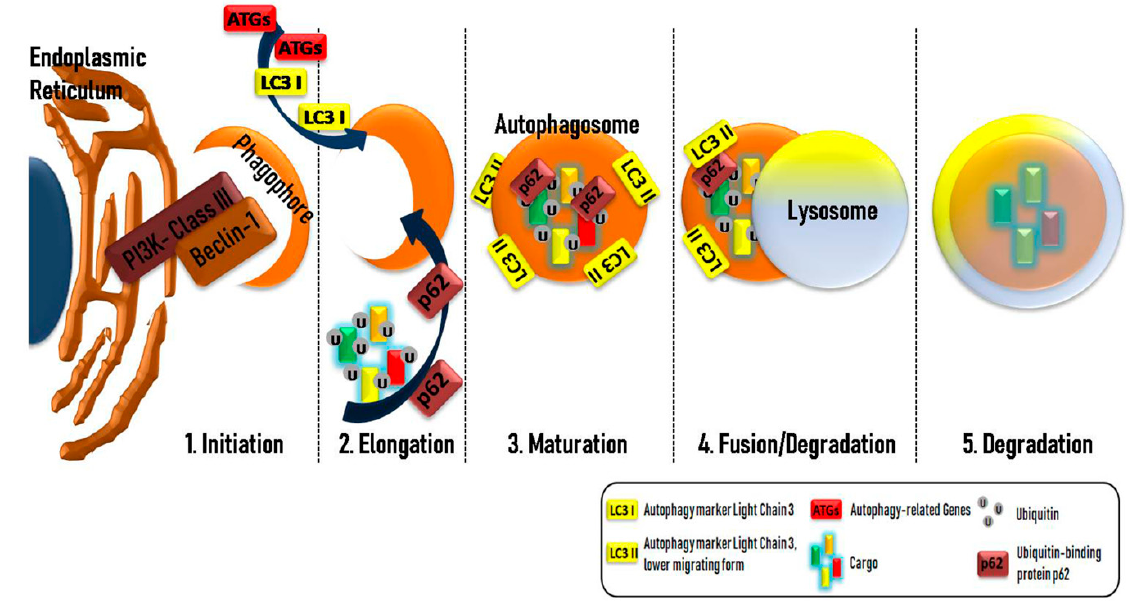
Figure 1. The main steps of autophagosome formation in cells. A plethora of different morphological changes occur during the autophagy process in order to form the autophagosome. The first step, or initiation (1), in this procedure, is the formation of a double-membrane structure, the phagophore, after the activation of a PI3K-classIII–Beclin-1 complex in the endoplasmic reticulum or other double-membrane organelles. Initiation is followed by the elongation (2) step, where the newly formed phagophore begins to enclose the ubiquitin-labeled cytosolic cargos. Different proteins, such as LC3 (light chain 3) (LC3-I is conjugated to phosphatidylethanolamine to form LC3-phosphatidylethanolamine conjugate or LC3-II, responsible for the autophagosomal membrane structure), Atgs (autophagy-related genes), and p62 (an adaptor protein responsible for the docking of cargos), have an essential role in the maturation (3) step, where the autophagosome has already formed. The fusion of the lysosome and autophagosome in the fusion/degradation (4) step creates the autolysosome where, in the degradation step (5), the cytosolic cargos are digested by lysosomal enzymes and the products are released into the cytosol.